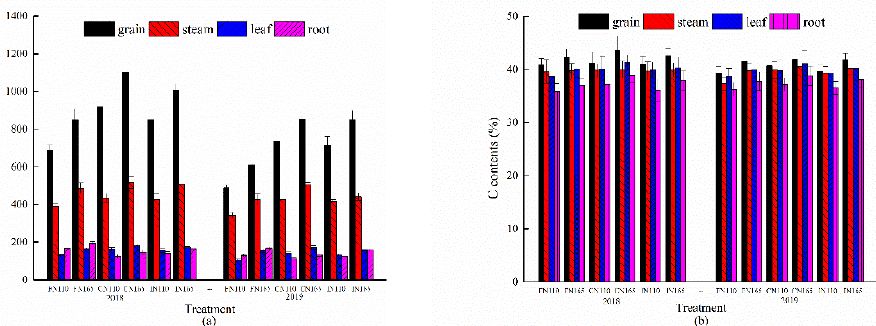
Figure 2. Changes of ( a ) dried matter weight and ( b ) their C contents in paddy fields after the im- plementation of water-saving irrigation. Table 2. Changes in NPP components in paddy fields after the implementation of water-saving ir- rigation